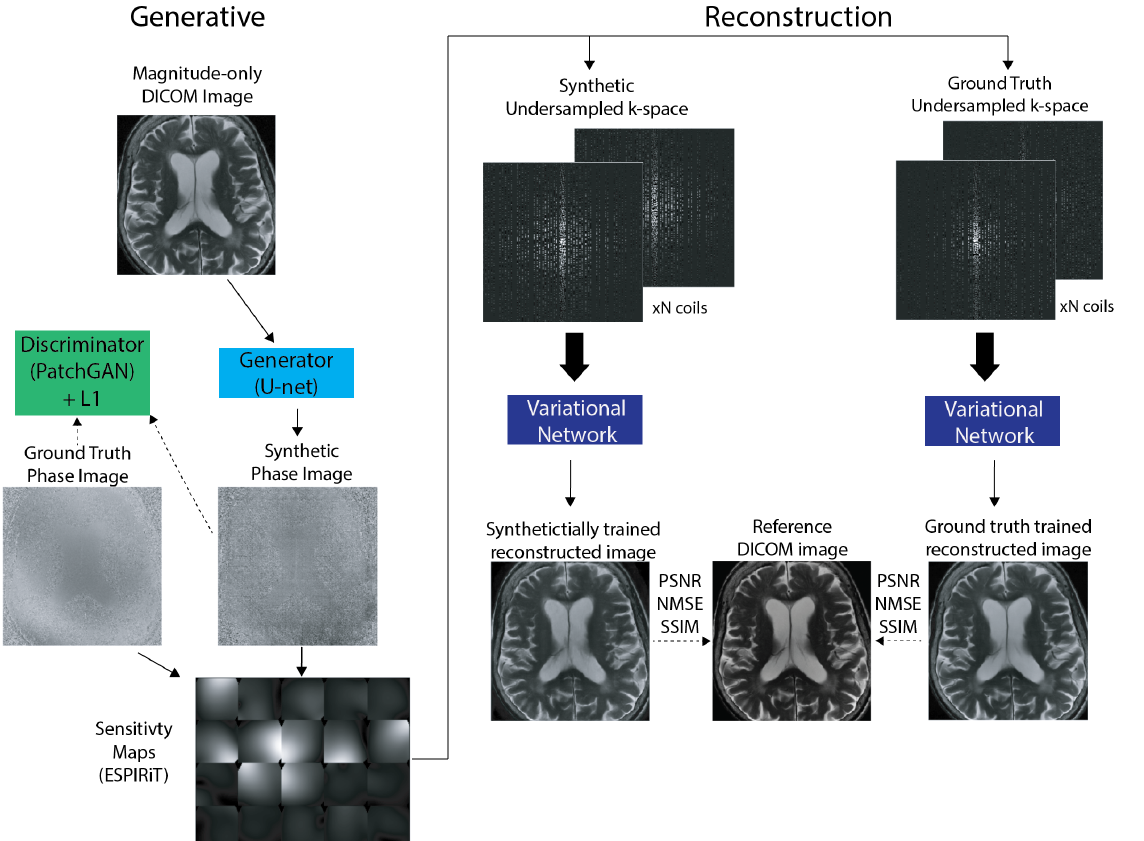
Figure 1. The proposed synthetic raw data generation and image reconstruction pipeline. The generative model takes magnitude images as an input seed and produces plausible synthetic phase images as output, which are trained to match ground truth phase images from the dataset. Synthetic complex-valued data is obtained by combining the input (ground truth) magnitude image and synthetic phase image to yield real and imaginary components. Estimated sensitivity maps calculated with ESPIRiT from the training dataset are then applied to synthetic complex-valued multi-coil data to compute multi-coil k -space encoded with synthetic phase information. The synthetic raw data were evaluated by training a Variational Network using undersampled k -space